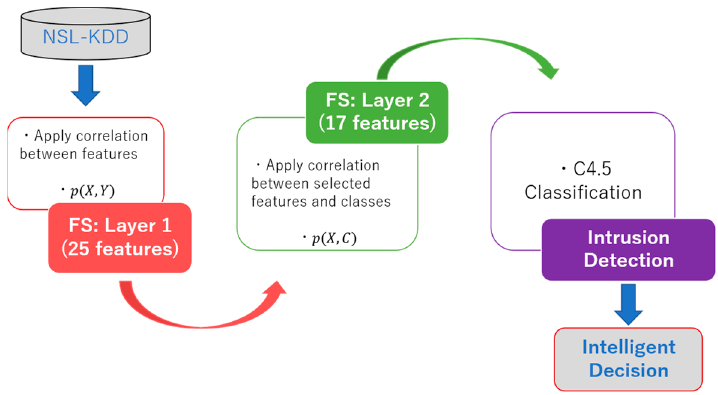
Figure 1. The proposed NID model based on linear correlation.